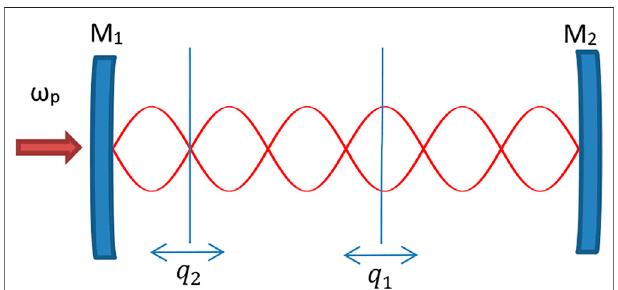
FIGURE 1 | Schematic diagram of a Fabry – Pérot optical cavity coupling with two partially transparent dielectric membranes which can be looked as twooscillators.Thepositionsofmembranes1and2incavityareexpressedas q 1 and q 2 ,